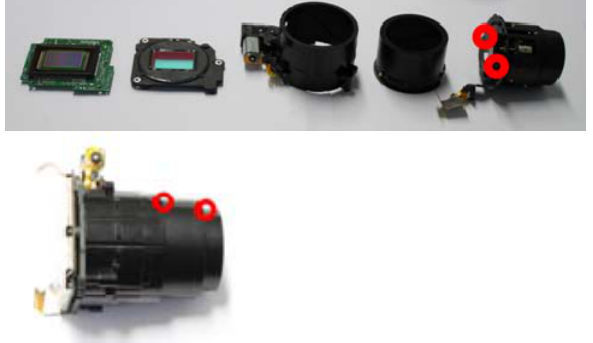
Figure 4. Gluing points at the Sigma DP1 lens